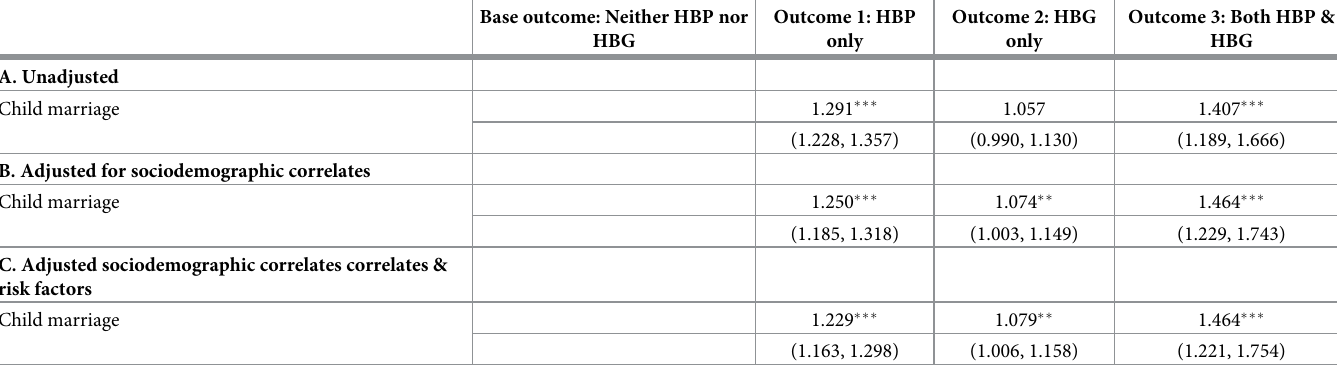
Results for the adolescent motherhood, the alternative measure of child marriage, are pre- sented in Table 4. The correlation between age at first birth and age at first marriage in our Table 3. Unadjusted and adjusted relative risk ratios for child marriage